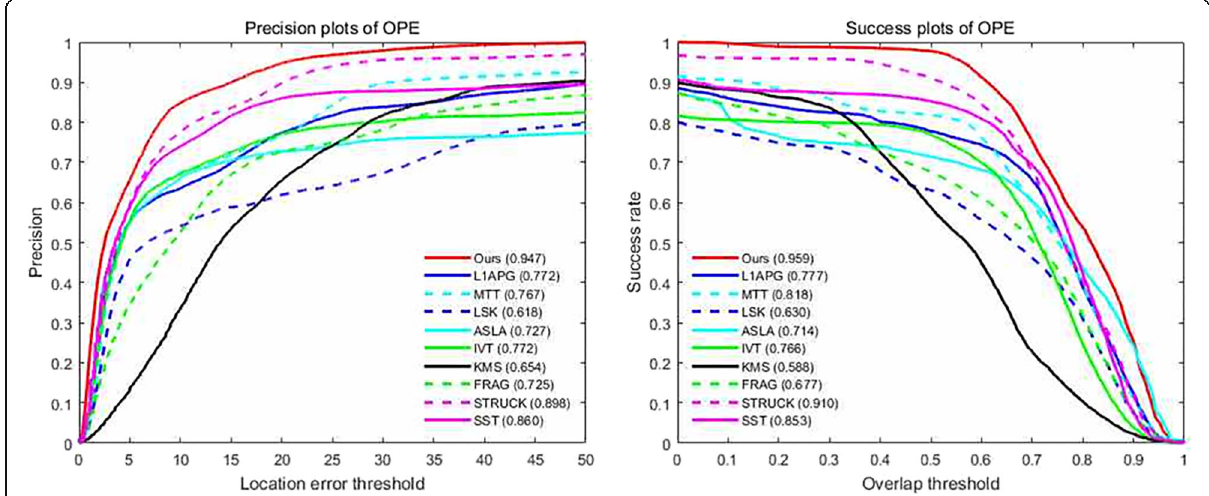
Fig. 5 Precision and success plots on 12 sequences with 9 state-of-the-art trackers